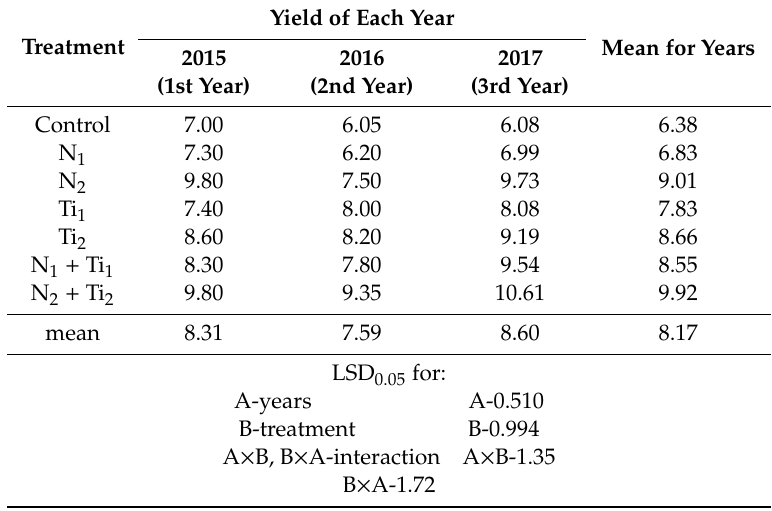
Table 2. The yield of Festulolium braunii (t ha − 1 DM). Yield of Each Treatment